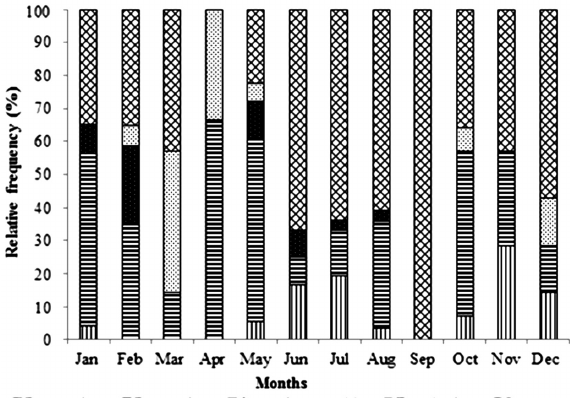
Fig. 3. – Relative frequency of maturity stages of male dolphinfish, Coryphaena hippurus (n=175) caught in the vicinity of the Saint Peter and Saint Paul Archipelago between 2007 and 2011.